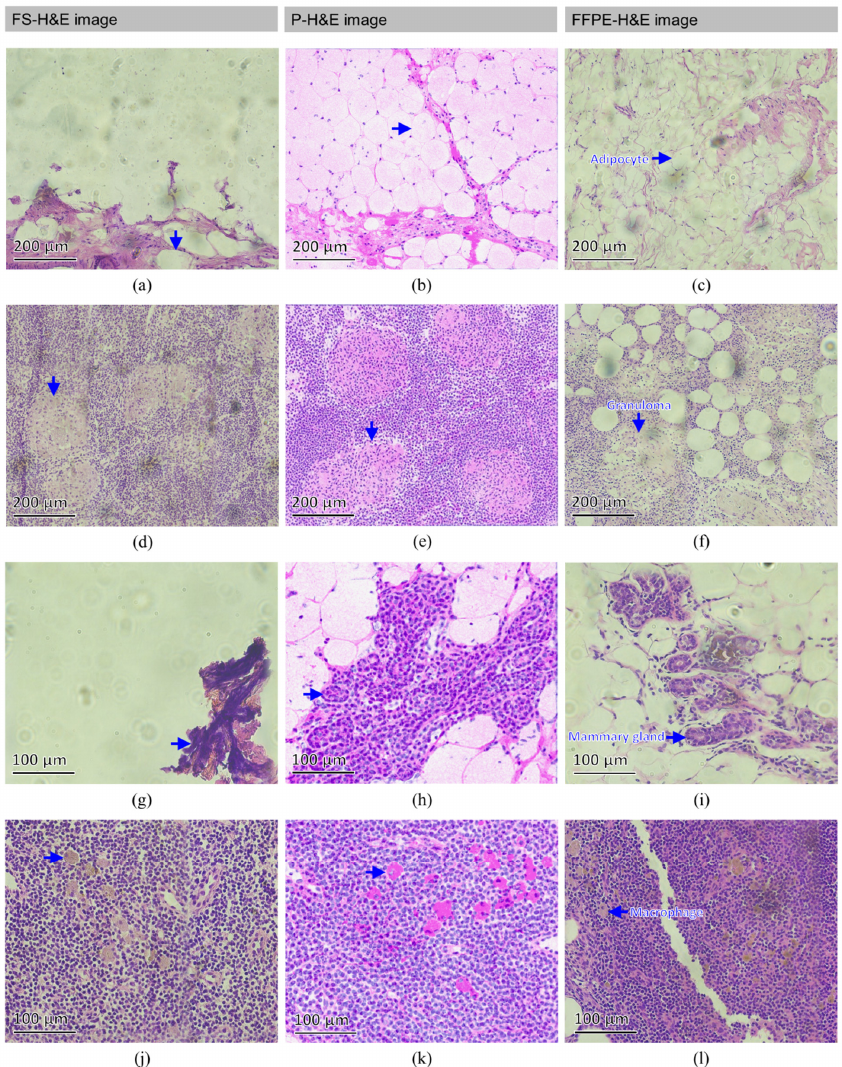
Figure 6. Featured positions of FS-H&E, p-H&E, and FFPE-H&E images acquired from the same normal SLNs of individual patients. Blue arrows in ( a – c ) indicate the fat areas from the same normal SLN #B of patient #6. Blue arrows in ( d – f ) indicate the plural granulomatous regions in the cortex of the same normal SLN #A1 of patient #7. In ( g – i ), the mammary glands (blue arrows) are sectioned with ductal morphology from the same normal SLN #B of patient #11. In ( j – l ), many macrophages (blue arrows) can be seen to have gathered at certain positions from the same nor- mal SLN #A of patient #6.